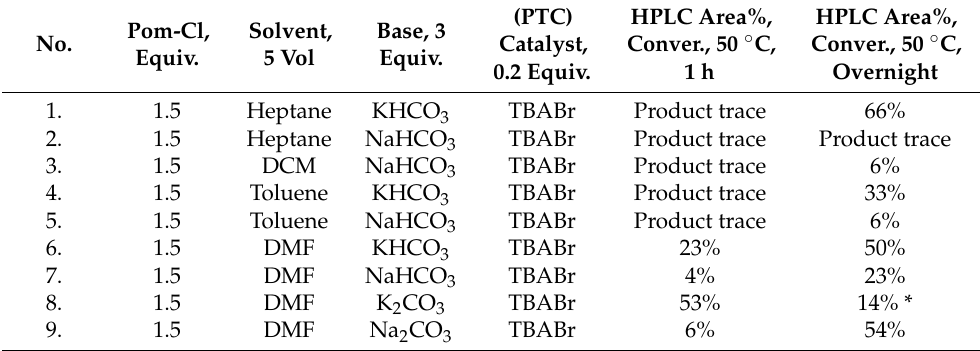
Table 1. Screen for suitable conditions for N 3 alkylation of 5-methyl uridine intermediate.